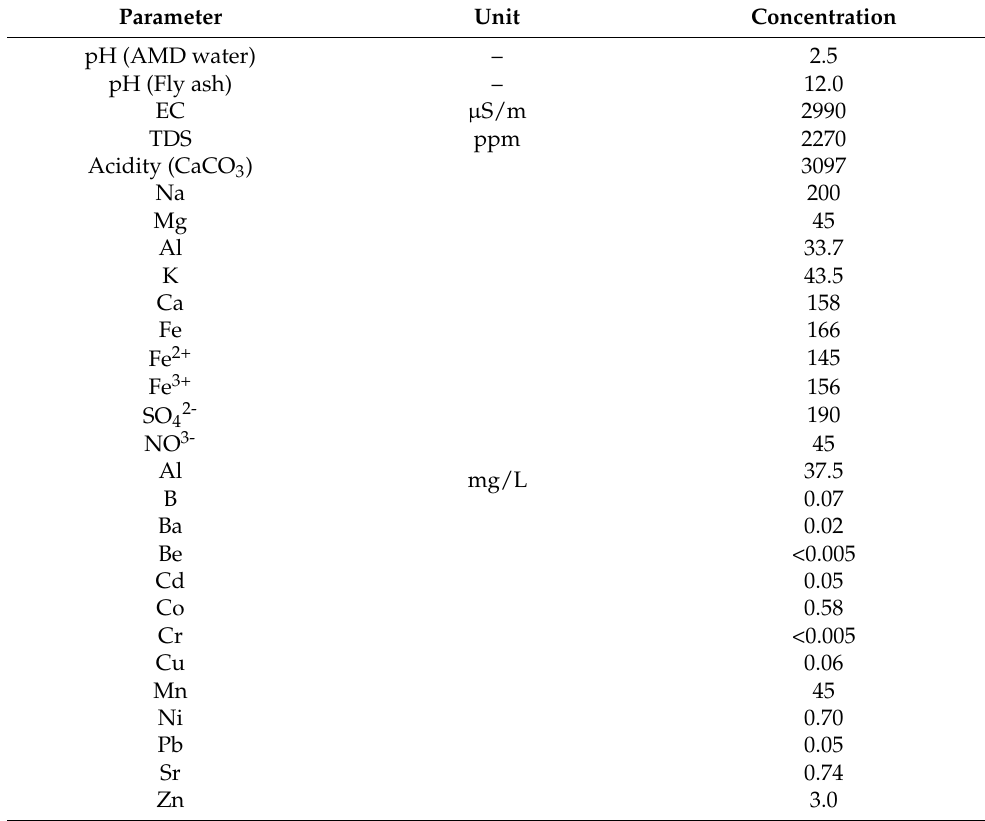
Table 3. Physicochemical characteristics of the AMD water.